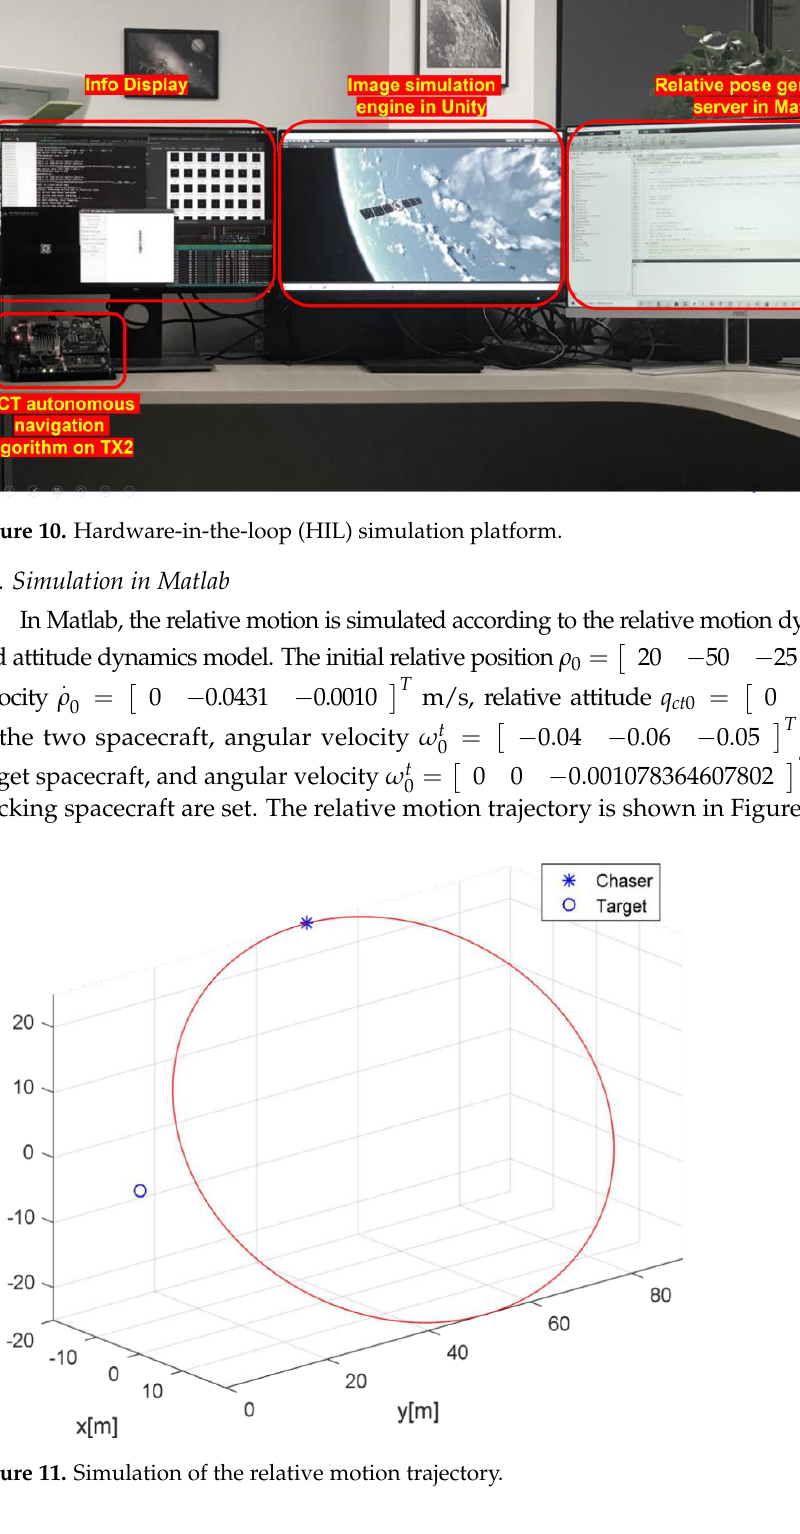
Figure 9. Configuration of hardware-in-the-loop (HIL) simulation platform. NCT autonomous nav- igation algorithm is deployed on a pose calculation computer, i.e., NVIDIA JetsonTX2 (NVIDIA Corporation, Inc., Santa Clara, CA, USA) module.